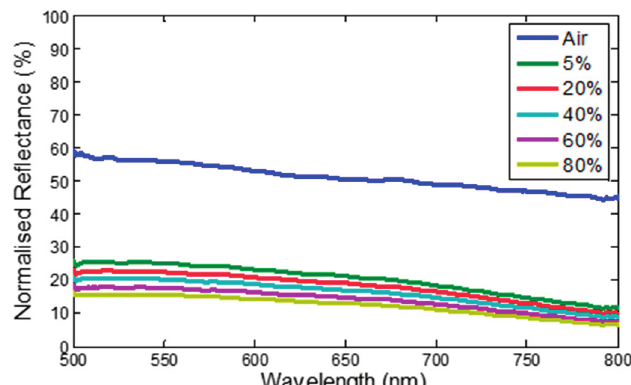
Figure 6. Reflectance spectra of sensor with different ethanol concentrations in distilled